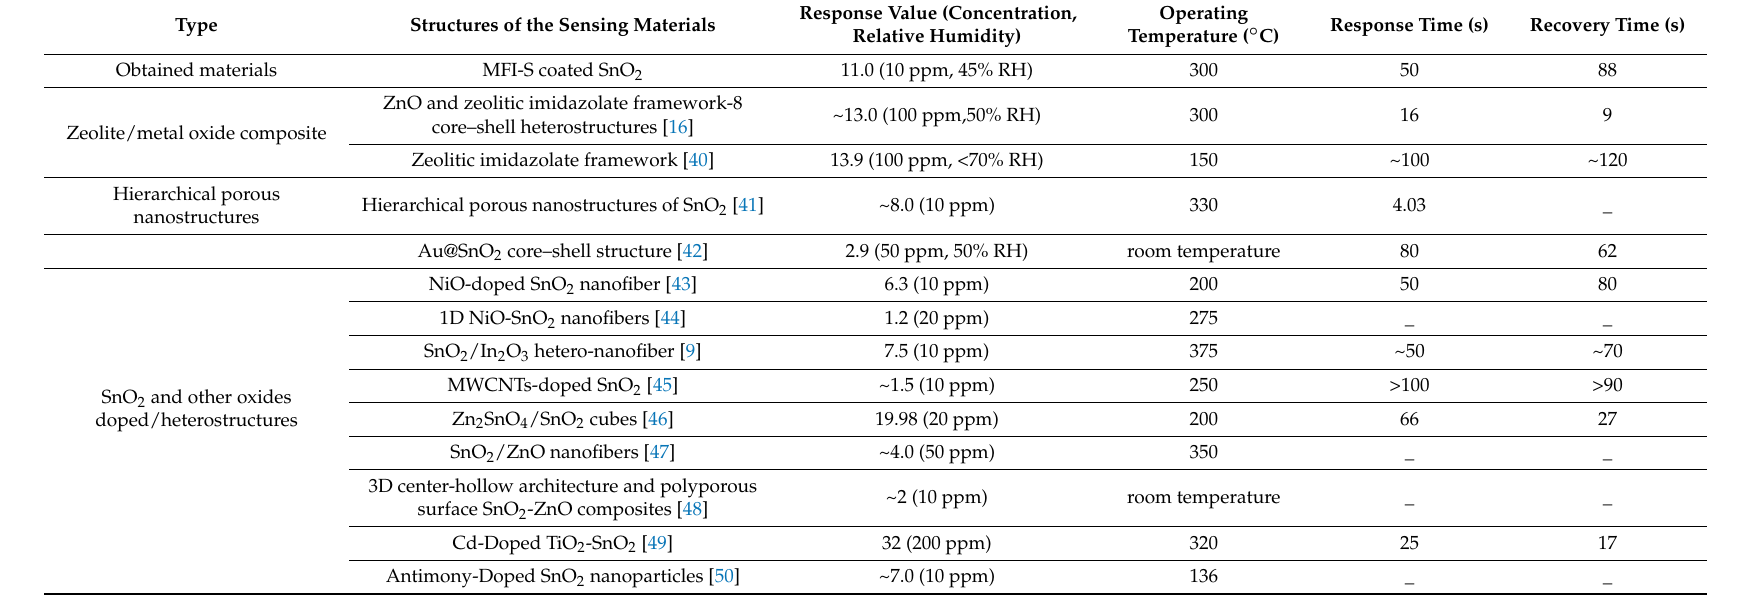
Table 3. The comparison on sensing properties of some similar structures sensors for formaldehyde gas